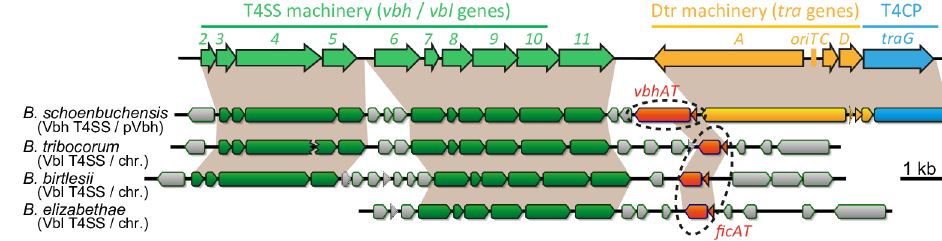
Fig 2. BtrFicTA and related FicTA modules are encoded with deteriorated conjugative T4SS machineries. Loci encoding bacterialconjugation systems consist of genesfor the T4SS machinery (green), the Dtr machinery (yellow),and a type IV couplingprotein (T4CP) that links these functions by recruiting the Dtr machinery to the T4SS (blue). Like VbhTA on pVbh, BtrFicTA of B . tribocorum and its orthologsare encodeddirectly downstream of the T4SS machineries(annotatedas Vbl T4SS for